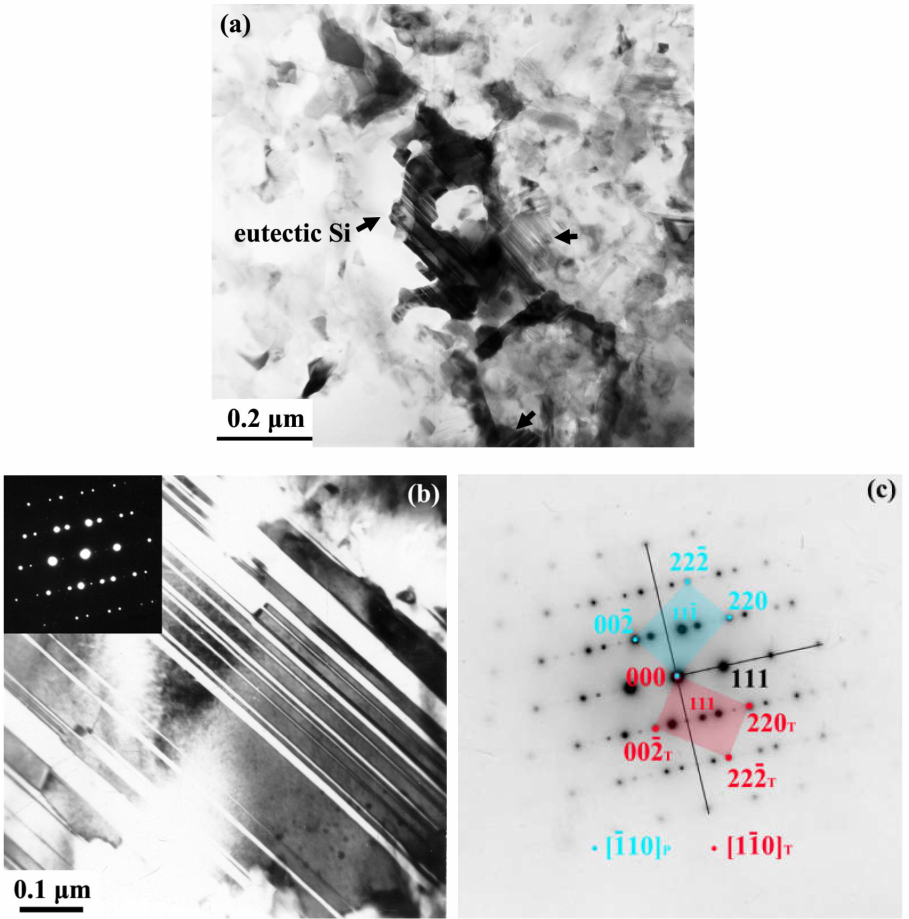
Figure 3. TEM images showing eutectic Si in the Si 3 N 4 w / Al-11.5Si-1.0Mg-0.5Cu-0.5Ni composite: ( a ) Eutectic Si particles; ( b ) Twinning in the eutectic Si; and ( c ) The corresponding selected area di ff raction pattern (SADP) in Figure